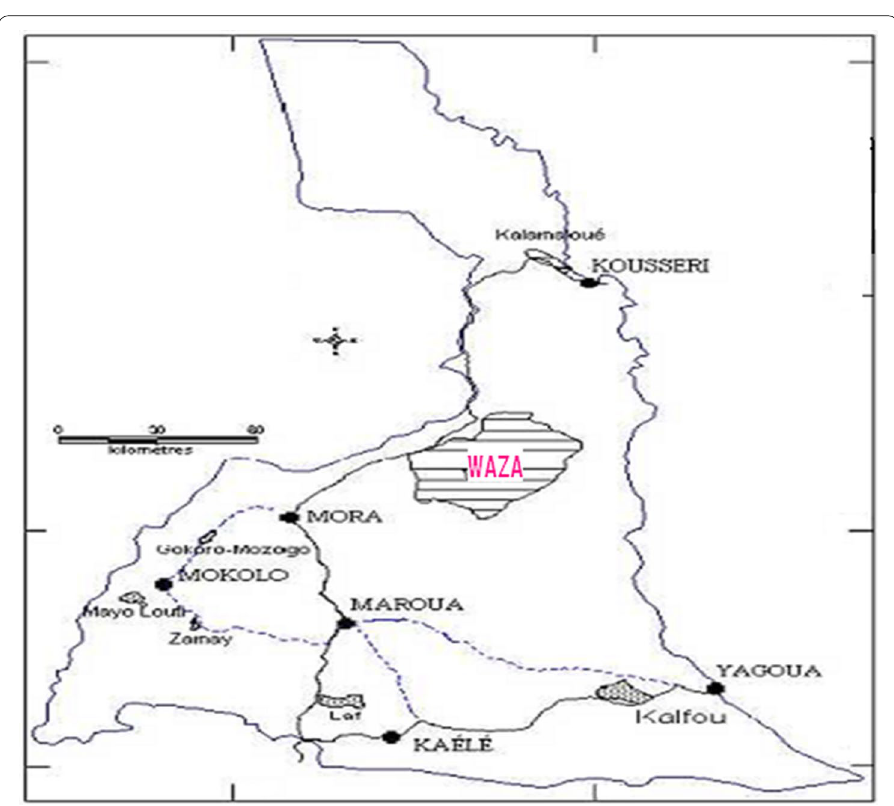
Fig. 2 Localization of the studied site (in red color) on geographic map